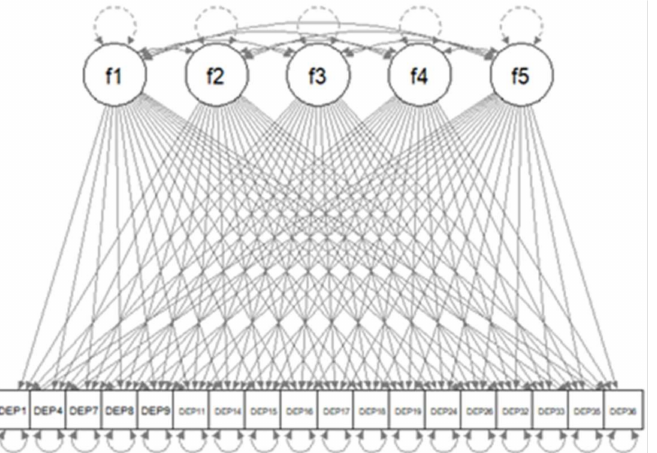
Figure 1. Path diagram of SEM model with five latent factors and with all cross-loadings specified.